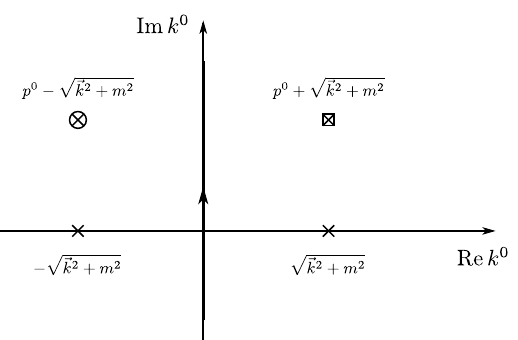
Figure 6. Integration contour for external Euclidean momenta.